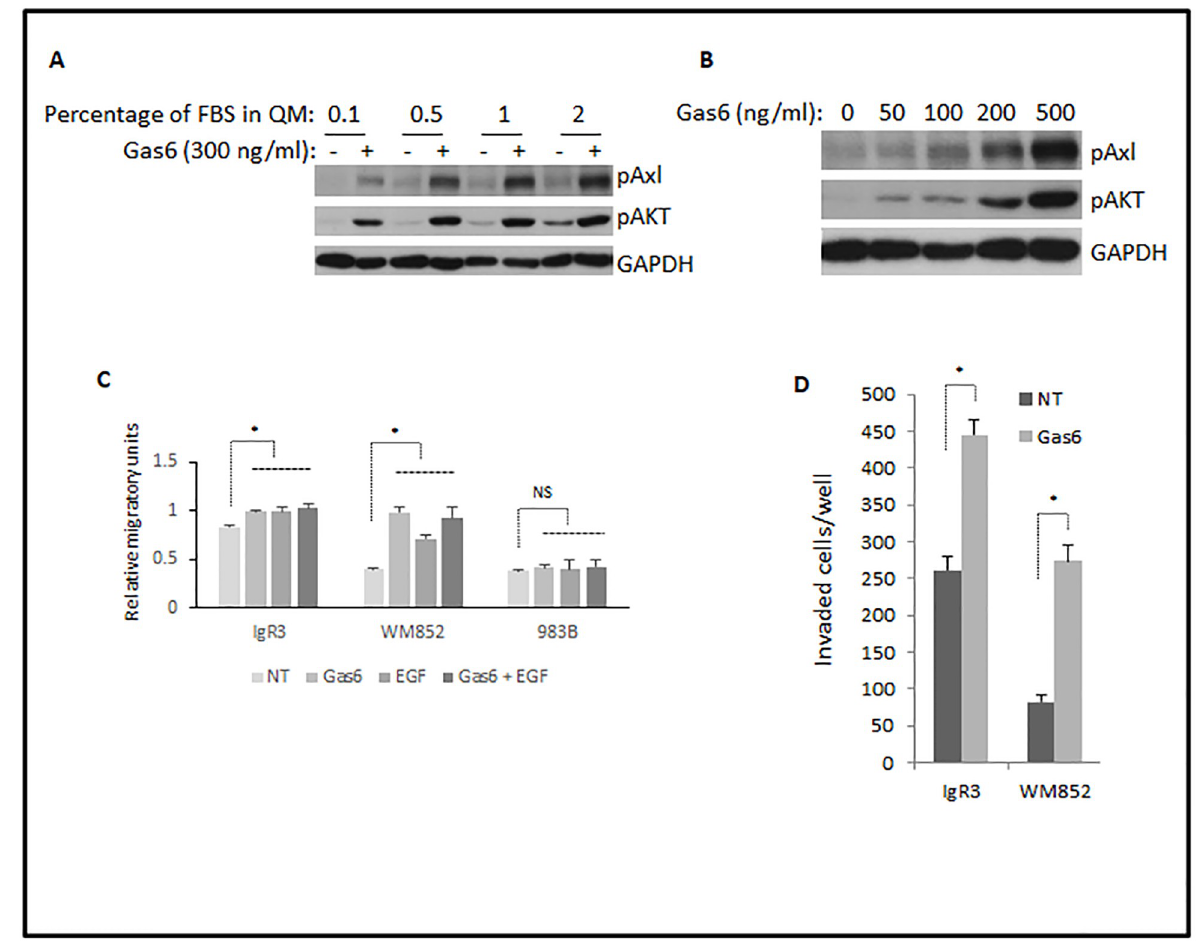
Fig 3. Gas6 promotes migration and invasion of melanoma cells in vitro . (A) Immunoblotting of indicated proteins extracted from WM852 cells quiesced in quiescent media containing indicated percentage of dialyzed FBS and stimulated with 300 ng/ml Gas6 for 15min. (B) WM852 cells were quiesced in 0.5% FBS quiescent media for 16h and then stimulated with indicated concentration of Gas-6 for 15min. Immunoblottings were performed using indicated antibodies. Shown are representative of three experiments. (C) Quantitative results of relative migratory speed of indicated melanoma cell lines stimulated with indicated factors for 24h. (C) Quantitative results of invaded IgR3 and WM852 with or without an attraction of 500 ng/ml Gas6 for 48h. Data are mean of ± SD of three independent experiments. Statistical analysis was performed using Student’s t- test. � P < 0.05, NS: not